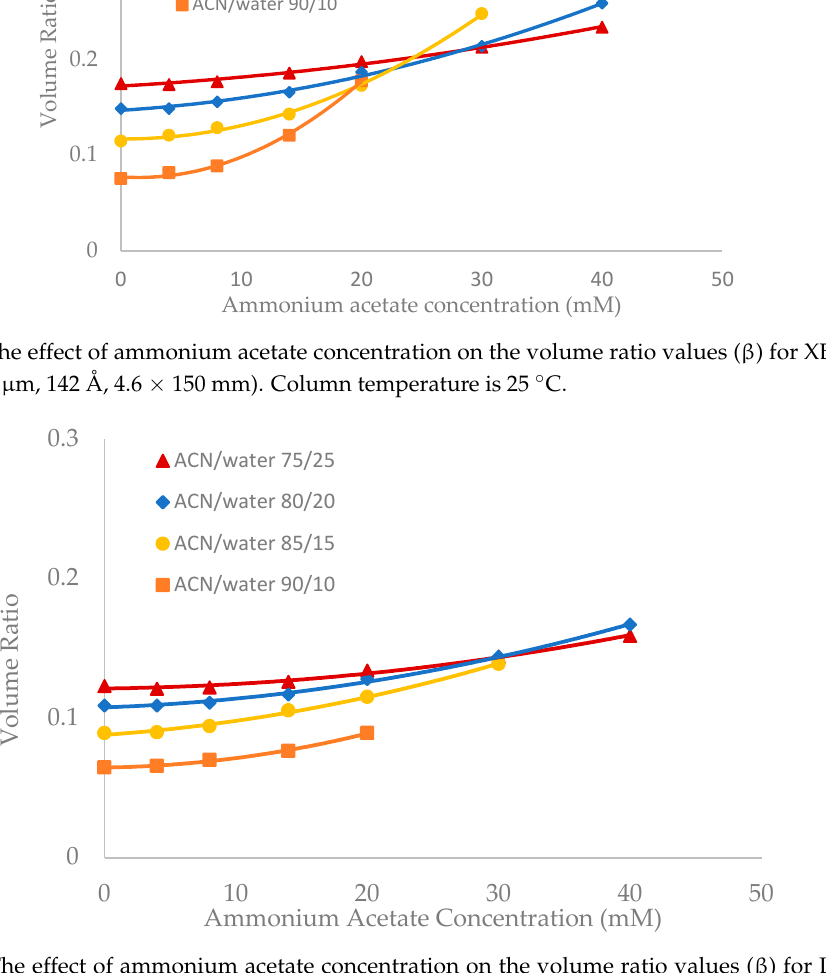
Figure 5. The effect of ammonium acetate concentration on the volume ratio values ( β ) for LUNA HILIC (3.0 µm, 187 Å, 4.6 × 150 mm). Column temperature is 25 °C.